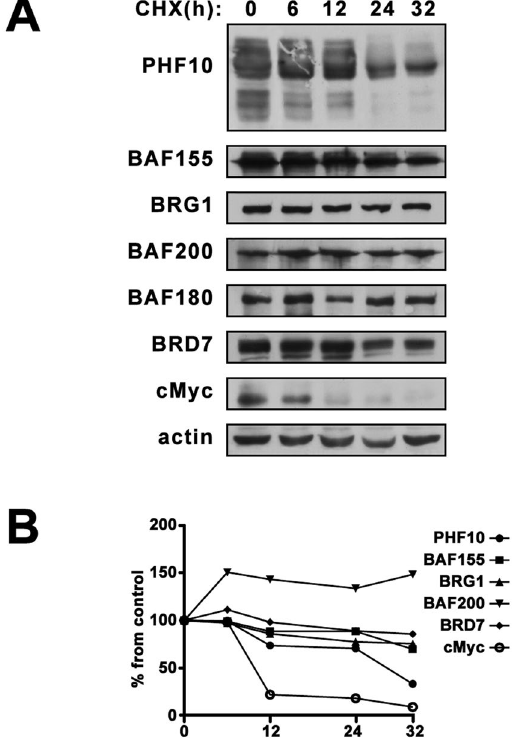
Figure 1. ( A ) The stability of PBAF subunits in human cells. HEK293 were treated with 20 µ g/ml cycloheximide (CHX) for the time points indicated above the panels. The equal amounts of lysates of control (0 h) and CHX- treated HEK293 were then analyzed by Western blotting. β -Actin was used as loading control. ( B ) The intensity of bands on Western blot was quantified using ImageJ software by densitometry as described in